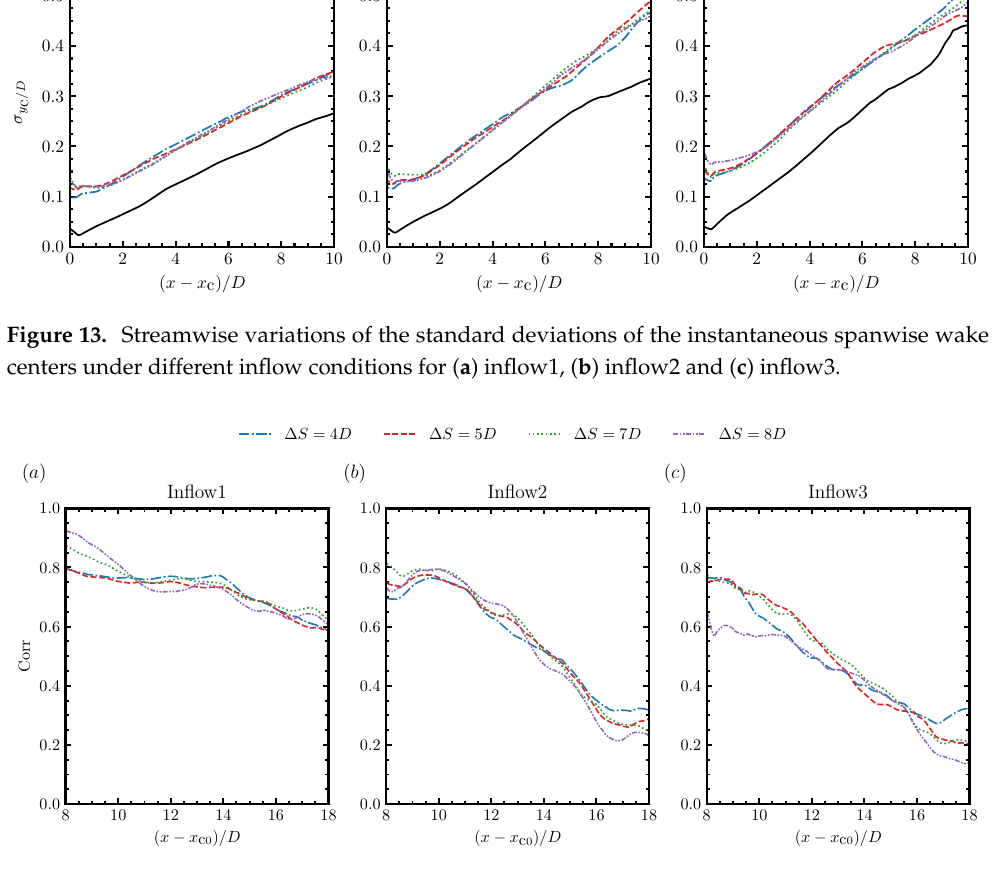
Figure 14. Correlation coefficients between the instantaneous spanwise wake positions of the waked turbine and those of the stand-alone wind turbine at different streamwise locations for ( a ) inflow1, ( b ) inflow2 and ( c ) inflow3,